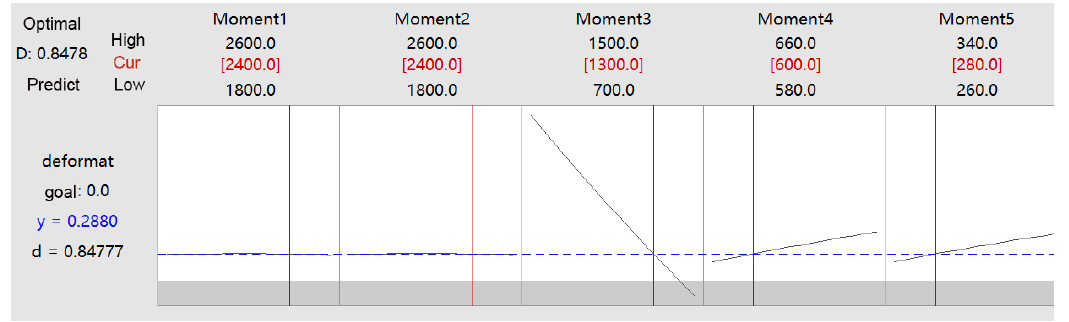
Figure 12. Interaction diagrams of the maximum amplitude displacement at the end of a series-parallel controllable mechanism welding robot (The sign * in the figure means the interaction of two factors).